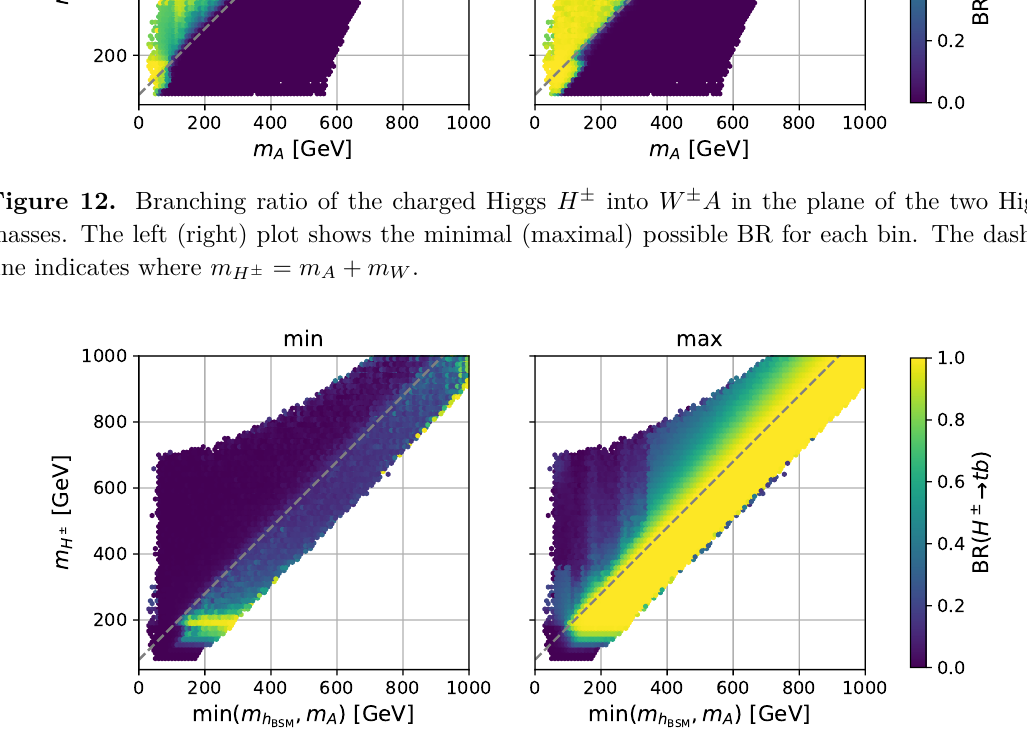
and the smaller Figure 13. Branching ratio of the charged Higgs H ± into tb in the plane of m H ± of the two non- h ( CP -even or CP -odd) neutral Higgs masses. The left (right) plot shows the 125 minimal (maximal) possible BR for each bin. For parameter points above the dashed line, at least one of the on-shell decay modes H ± → W ± h is BSM /A